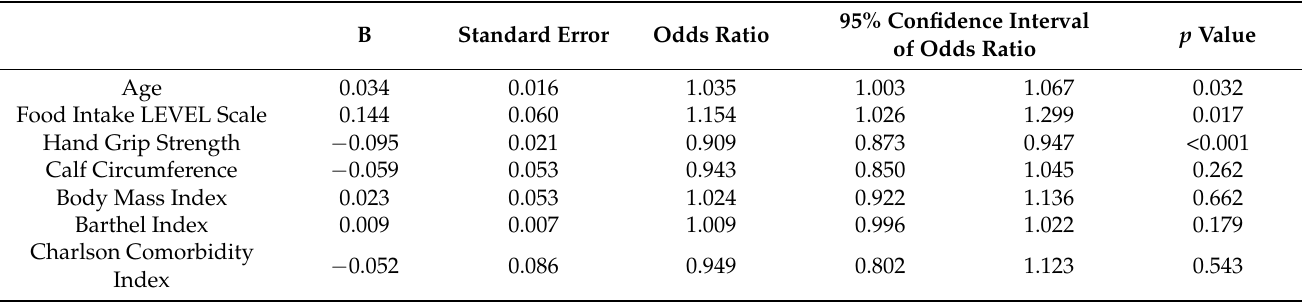
Table 2. Logistic Regression analysis of sarcopenic dysphagia